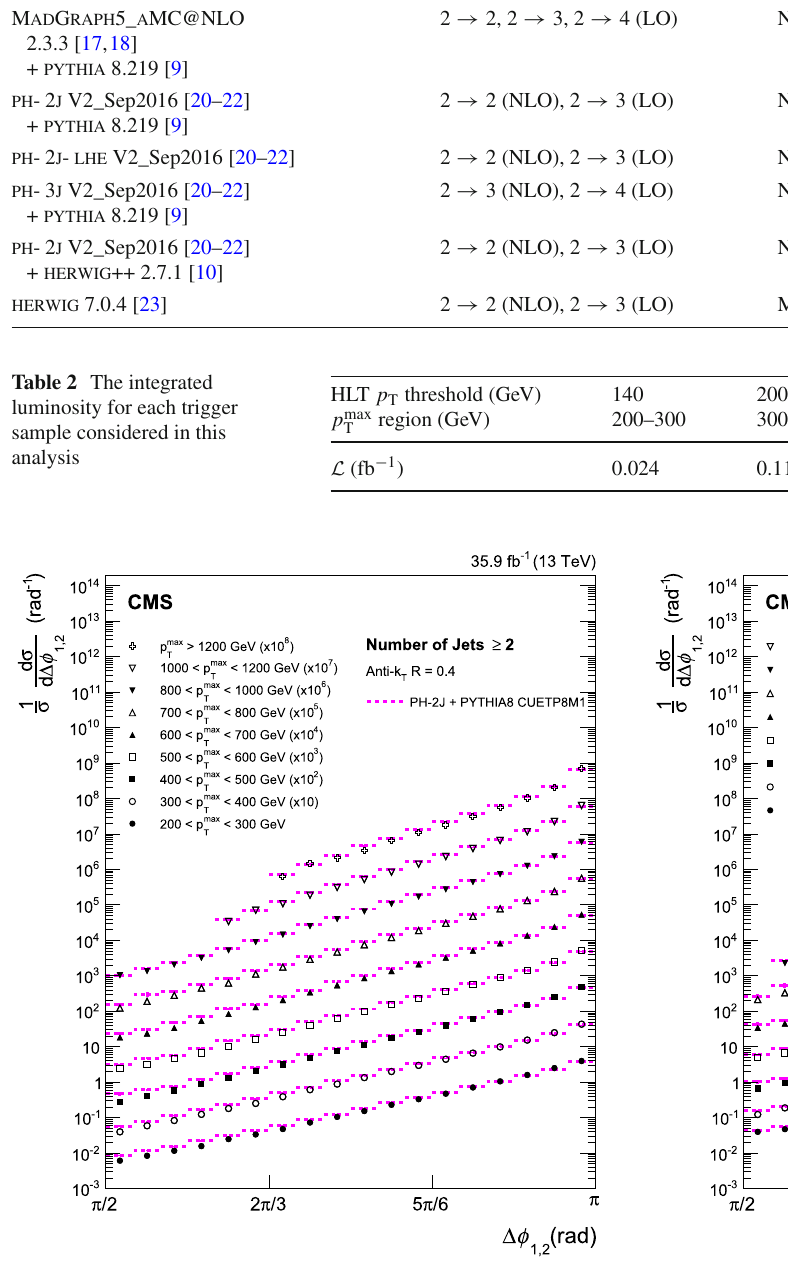
Fig. 1 Normalized inclusive 2-jet cross section differential in Δφ 1,2 for nine p max regions, scaled by multiplicative factors for presentation T purposes. The size of the data symbol includes both statistical and sys- tematic uncertainties. The data points are overlaid with the predictions from the ph- 2j + pythia 8 event generator